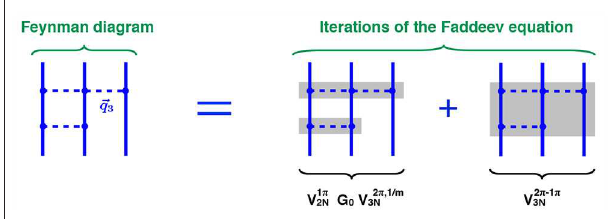
FIGURE 1 | Representation of the on-shell scattering amplitude from the one-pion-two-pion-exchange Feynman diagram (left) in terms of iterations of the Faddeev equation (right) . Gray-shaded rectangles visualize the corresponding two- and three-nucleon potentials V 1 π 2N , V 2 π ,1 / m 3N , and V 2 π − 1 π 3N while G 0 denotes the free resolvent operator for non-relativistic